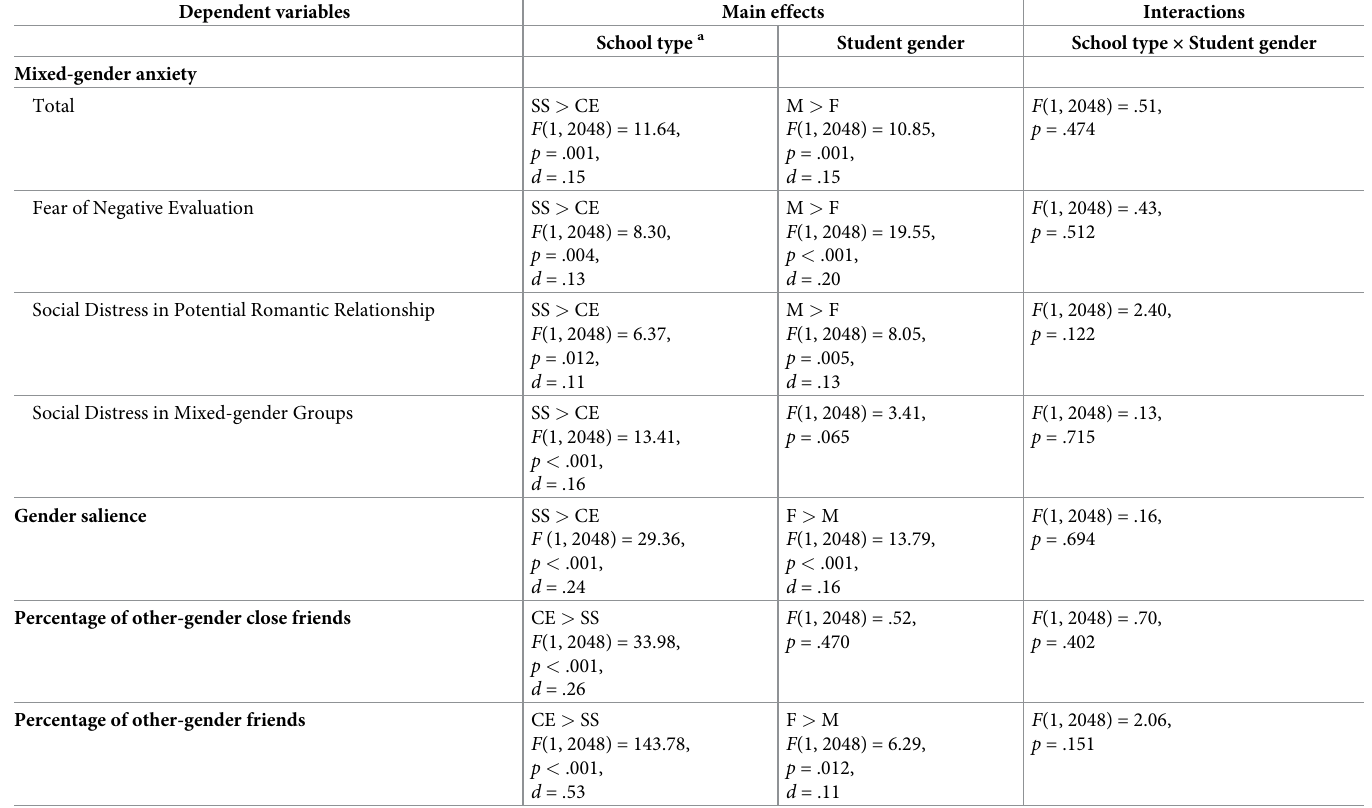
Table 3. 2 × 2 (School type × Student gender) ANCOVA results (Study 1: High school sample). Dependent variables